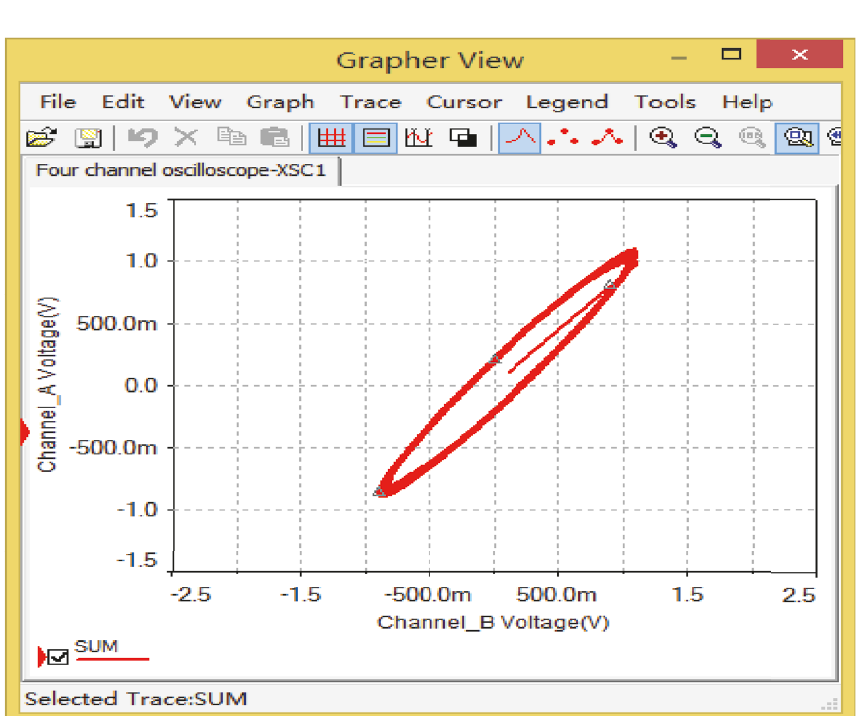
Figure 24: Phase portrait of 500